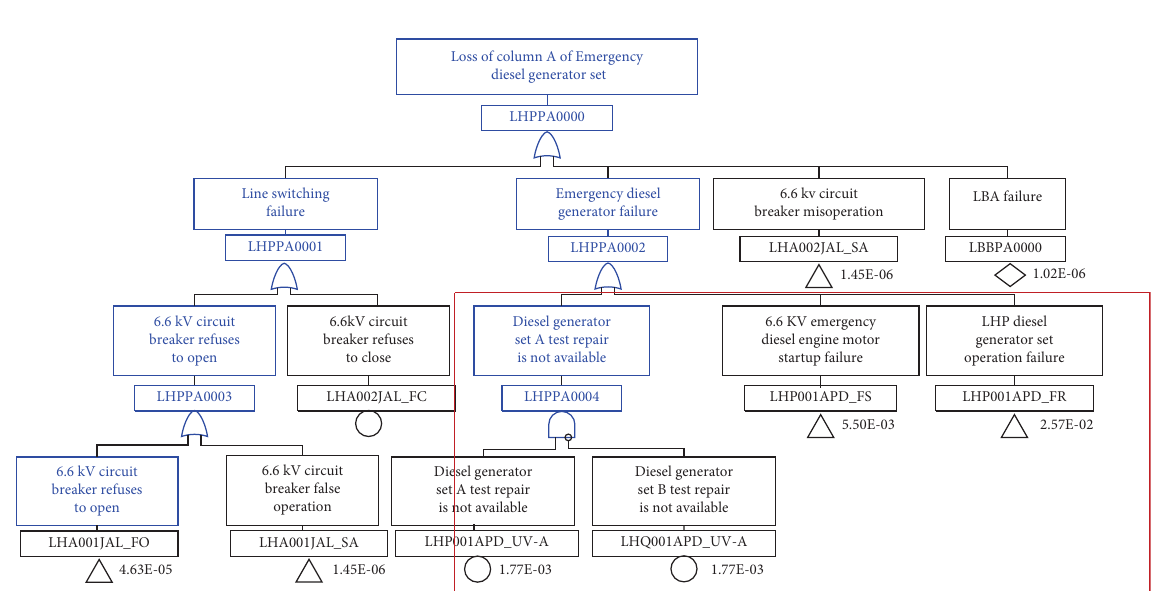
Figure 4: An NPP’s EDG fault tree